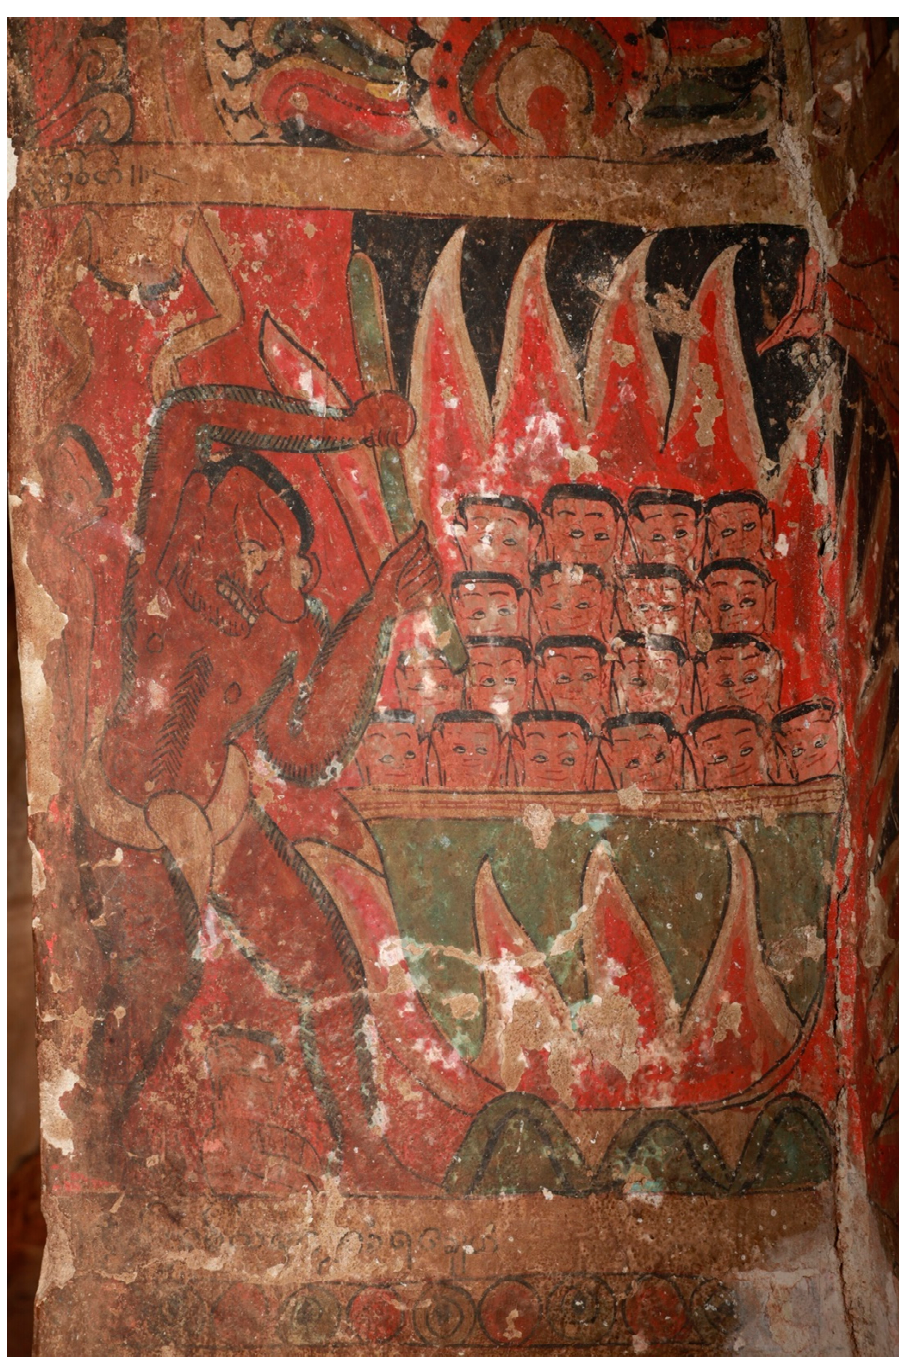
Figure 19. Anaint, Zeditawtaik. 18th century. Pots in which transgressors were cooked—one of the most popular and ancient images illustrating punishments in hell.